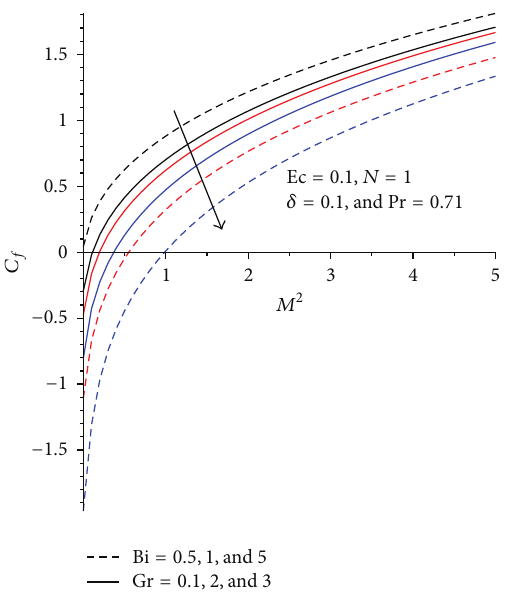
Figure 20: Skin friction with increasing 𝑀 , Bi, and Gr.